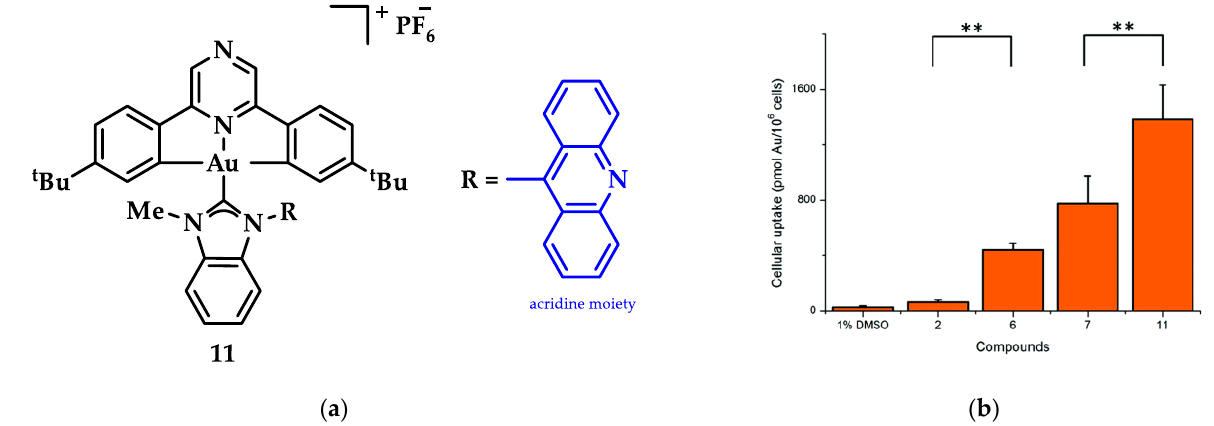
( b ) Figure 17. ( a ) Chemical structure of Au(III)-NHC pincer complex with R = n -butyl; ( b ) Antitumor activity in mice HeLa cells after treatment with 3 mg·kg −1 of 10 . * p < 0.05. Adapted with permission from Ref. [44] . Copyright (2017) Wiley-VCHVerlag GmbH&Co. KGaA, Weinheim. An Au(III)-NHC complexes containing acridine moieties (11), was synthesized by Bochmann et al. and compared to analogues without a NHC ligand (Figure 18a). Uptake studies revealed a correlation between cytotoxicity and uptake, and compound 11 has the highest antiproliferative activity against breast (MCF-7) cancer cells (IC 50 = 1.5 μ M, cispla- tin value 21.2 ± 3.9 μ M). Based on studies of this series of compounds, it is indicated that